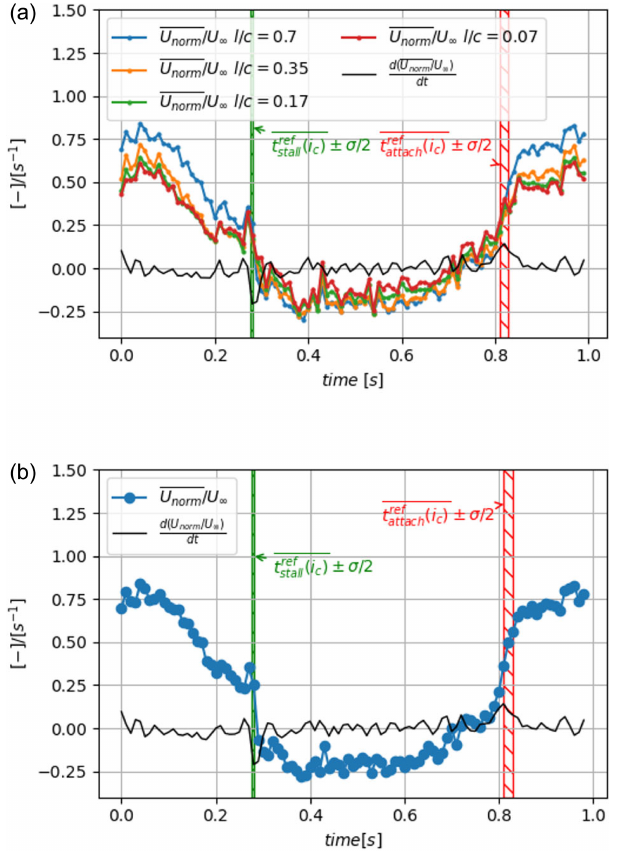
Figure 14. The phased-averaged signal of the first detection method U norm with its time derivative d U norm : (a) for different values of l/c d t and (b) for l/c = 0 . 7.